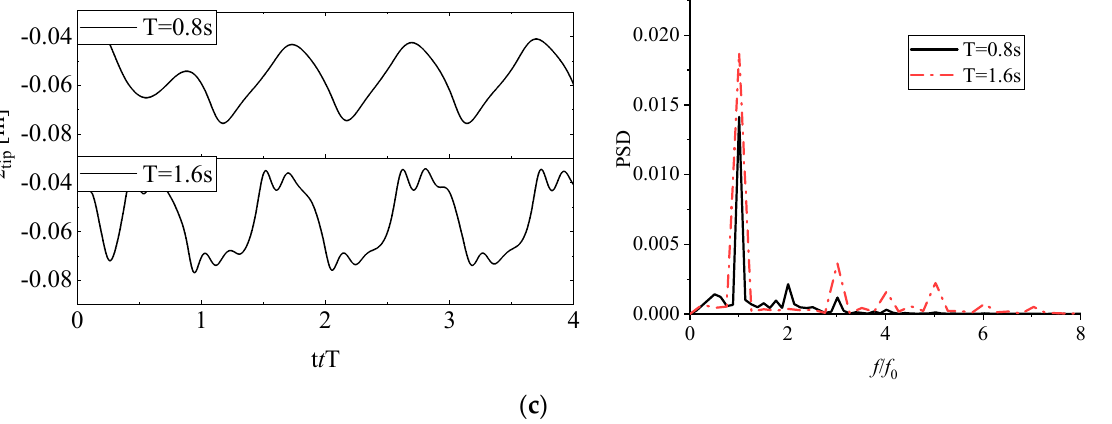
Figure 20. Time histories of the displacement of the membrane tip ( left ) and the FFT results ( right ) with ( a ) linear-elastic material ( b ) hyper-elastic M3 ( c ) hyper-elastic M4 ( H = 0.1 m and d = 0.18 m for T = 0.8 s and 1.6 s).